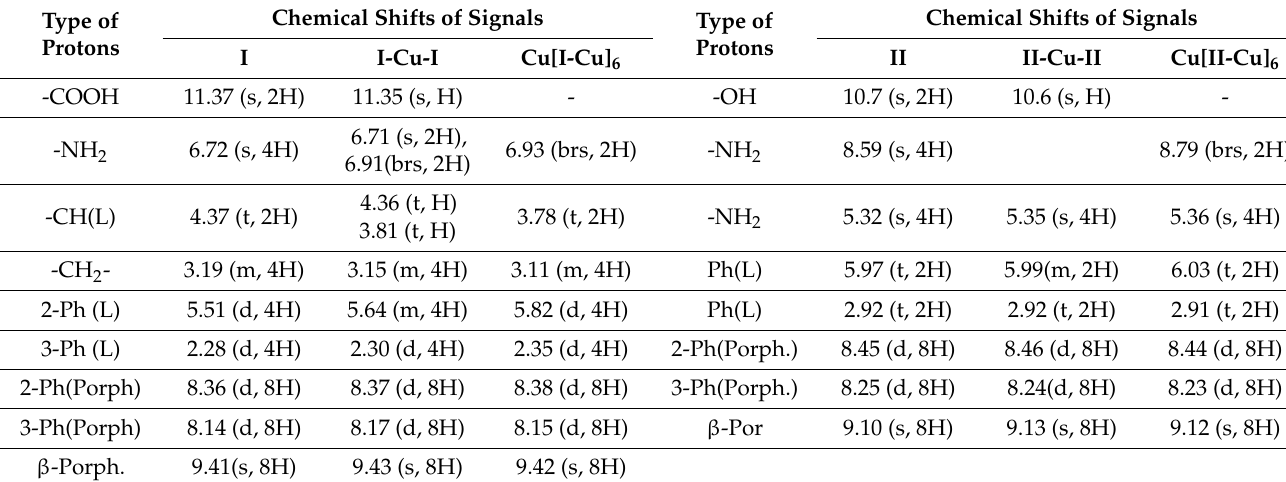
Table 6. Relevant 1 H-NMR signals for studied compounds.